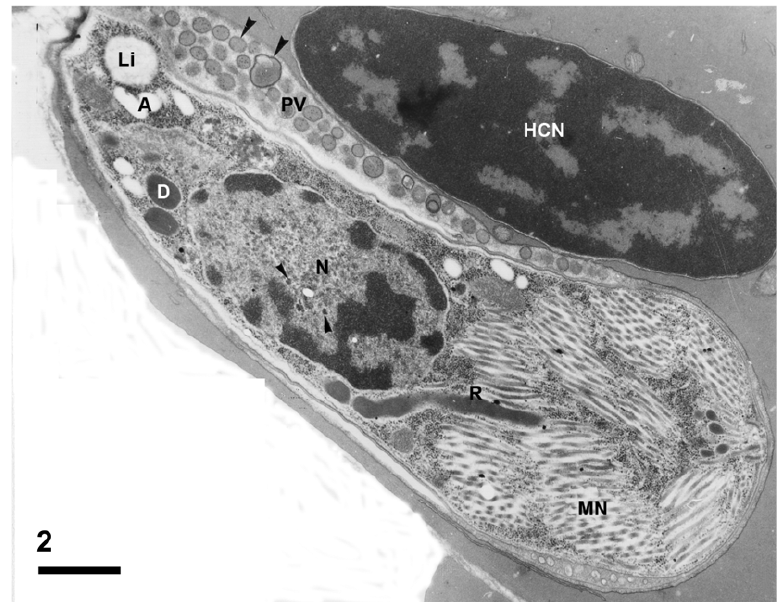
Fig. 2 – Routine transmission electron microscopy showing a trophozoite of Cyrilia lignieresi , a haemogregarine found in erythrocytes of a fresh-water fish. Structures such as lipidic in- clusions (Li), amilopectin granules (A), dense granules (D), rhoptries (R) and a large number of micronemes (M) are observed. Spherical bodies are seen within the flagellar pocket (small arrowheads). HCN, host cell nucleus. Bar, 1 µ m. After Diniz et al.